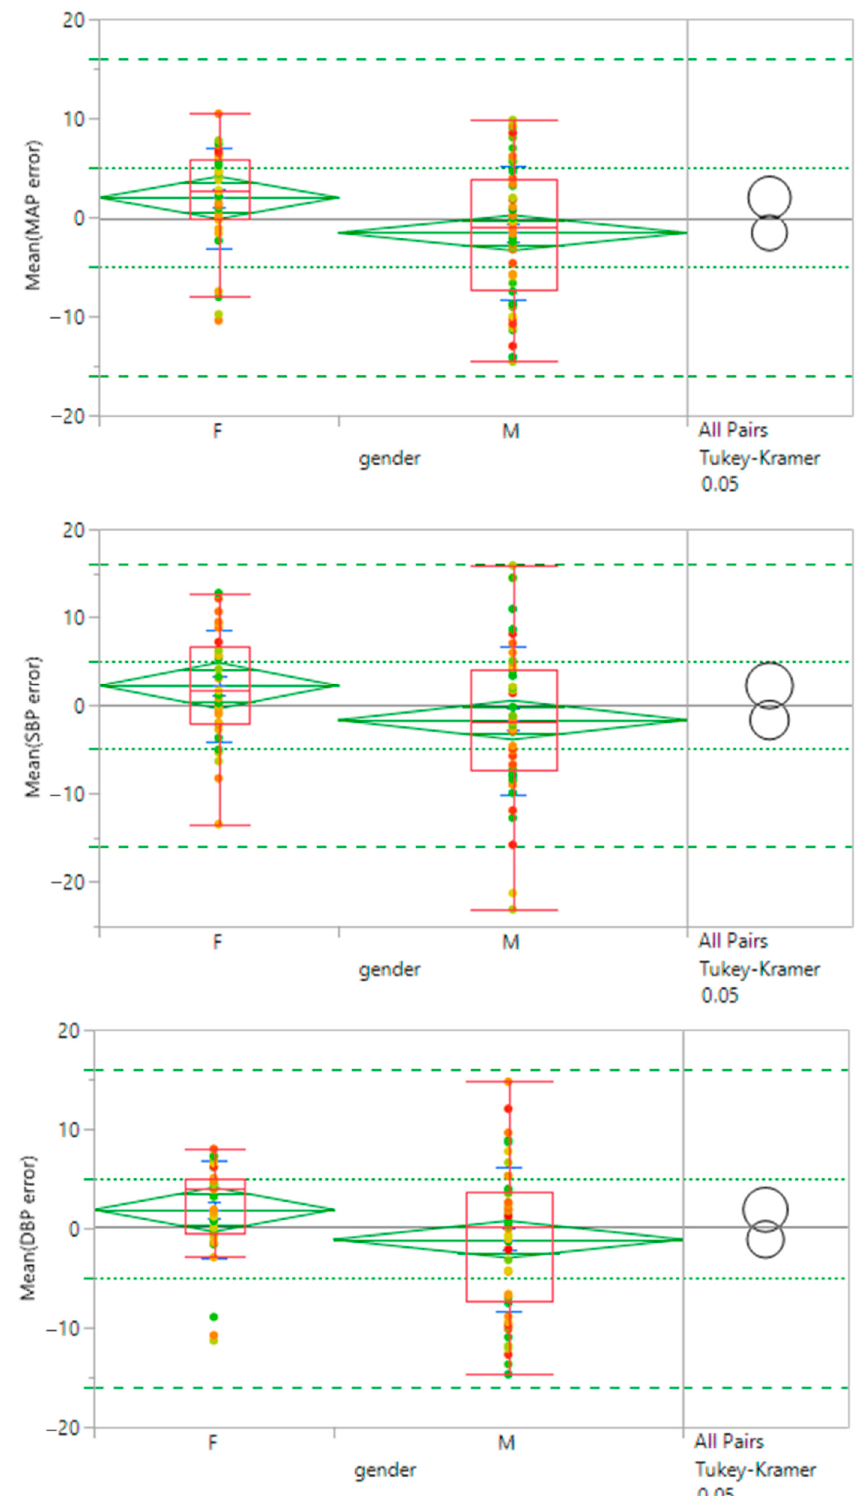
Figure 6. Effect of sex on efficacy. Female and male patient subsets are compared through mean diamonds (green) and Tukey–Kramer circles (black). Minimal overlap between diamonds and circles